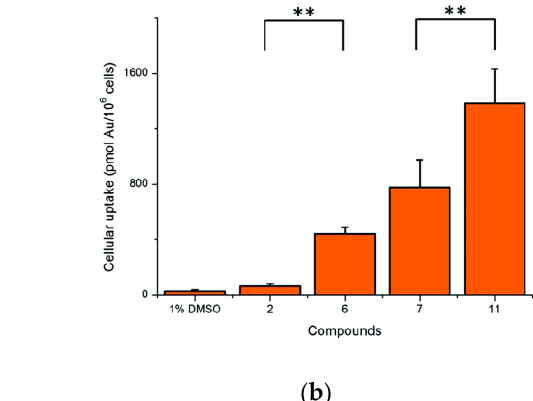
Figure 18. ( a ) Acridine-functionalized [(C^N pz ^C)Au III (NHC)] + complex; ( b ) Cellular uptake in MCF-7 cells (compound 11 ). ** p < 0.005. Adapted with permission from Ref. [144]. Copyright (2018) MCF-7 cells (compounds 11 ). ** p < 0.005. Adapted with permission from Ref. [144] . Copyright The Royal Society of Chemistry. (2018) The Royal Society of Chemistry.